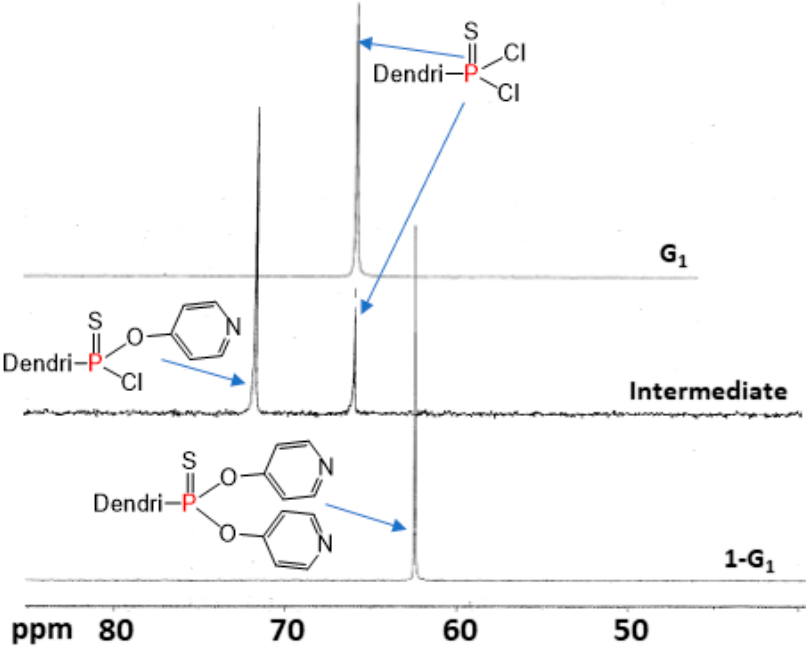
Figure 8. Changes in the 31 P { 1 H} NMR spectra during the synthesis of dendrimer 1-G 1 from G 1 . Only the part of the spectra corresponding to the terminal groups is shown.